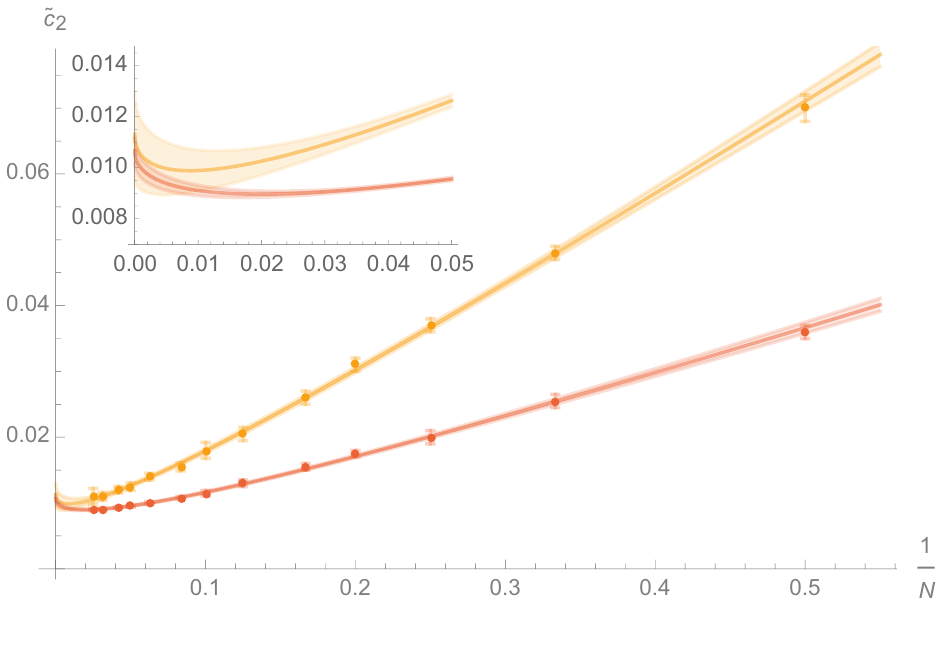
Figure 4 . l→↑↑ transition for c 4 = 0 . 001 , ν k = 0 and N ≤ 40 , observed as peaks in C (orange/top) e and χ (red/bottom). Pale-coloured stripes represent the 68% confidence intervals. The large N limit is